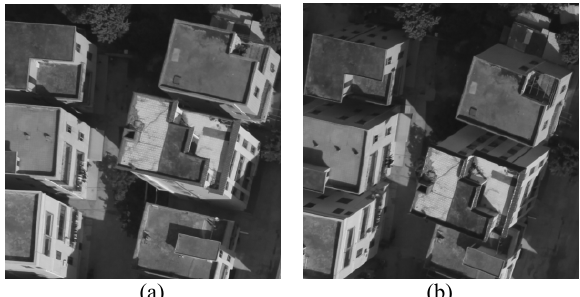
Fig.7 UAV image pair, the image size are 1000×1000 pixels